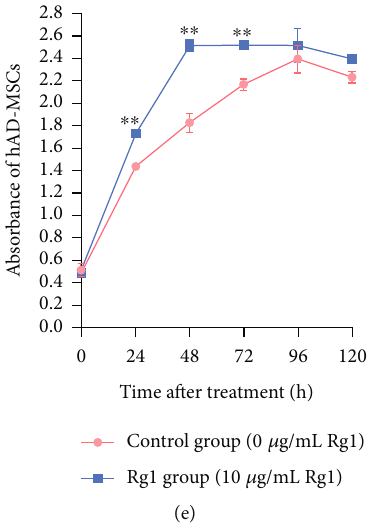
Figure 2: E ff ects of ginsenoside Rg1 on the proliferation of hAD-MSCs. (a, b) The cell cycle phase distribution of the control and Rg1 groups was analyzed (a) and compared (b) by fl ow cytometry ( n =3). A representative image of three independent experiments is shown in each group. (c, d) The hAD-MSC proliferation rates of the control and Rg1 groups were tested (c) and compared (d) by EdU incorporation assay (100x) ( n =6). Representative images are shown. Scale bars =100 μ m. (e) The growth curves of hAD-MSCs were detected using CCK-8 assay in the control and Rg1 groups ( n =6). ∗ P < 0 : 05 and ∗∗ P < 0 : 01